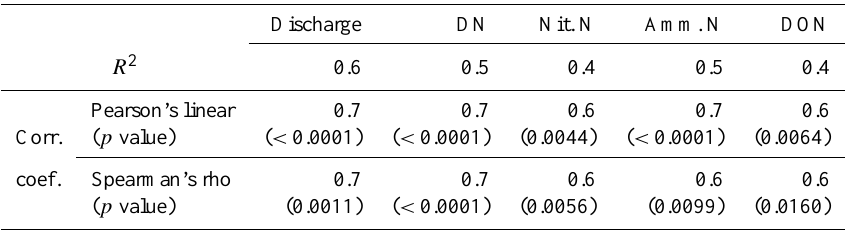
Table 5. Temporal evaluation of the annual stream discharges and N loads for the period 1987–2005 at Marietta. If a p value is smaller than 0.05, the correlation between the modeled and reported data is significantly different from zero.